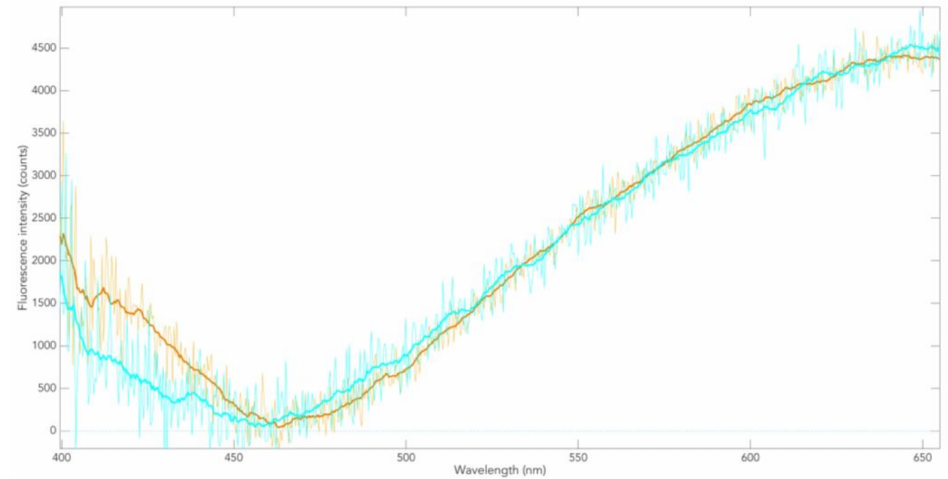
Figure 7. Fluorescence spectrum of NM in the postmortem SNpc of controls (blue line) and in a Parkinson patient (green